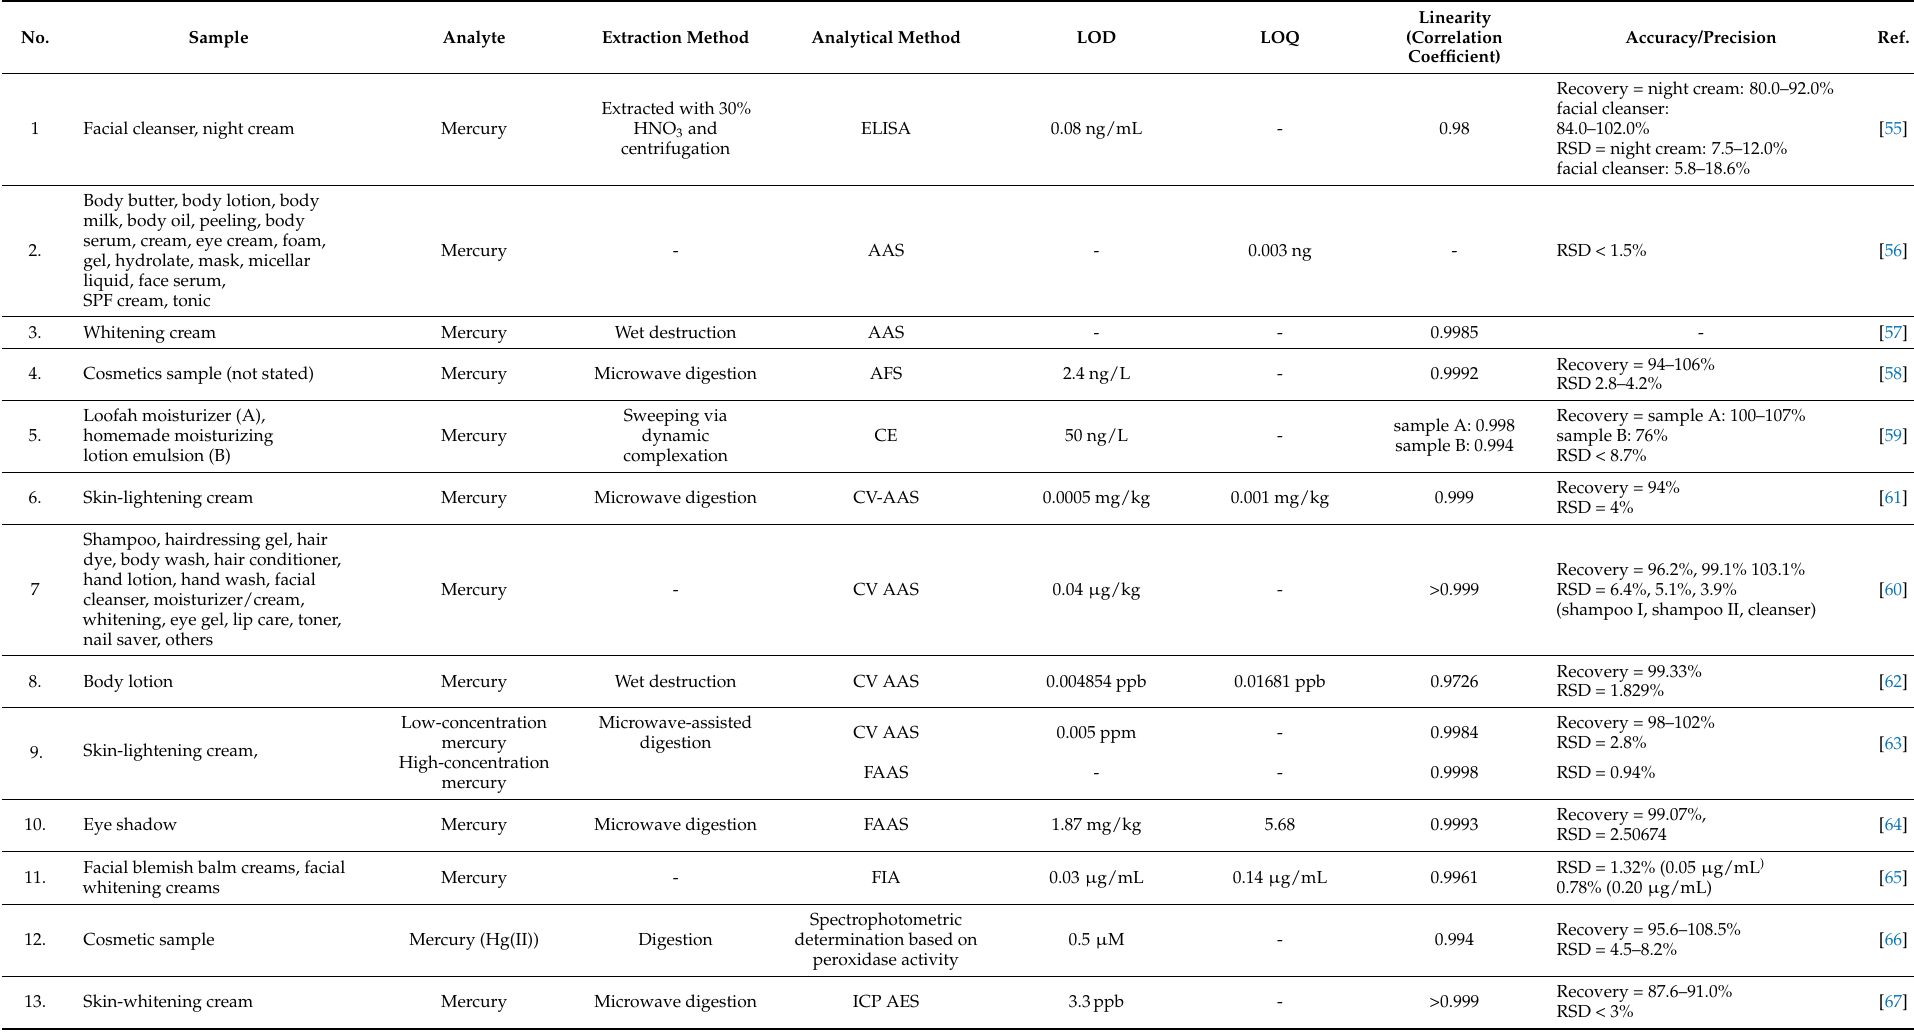
Table 10. Analytical method for determining mercury compounds in